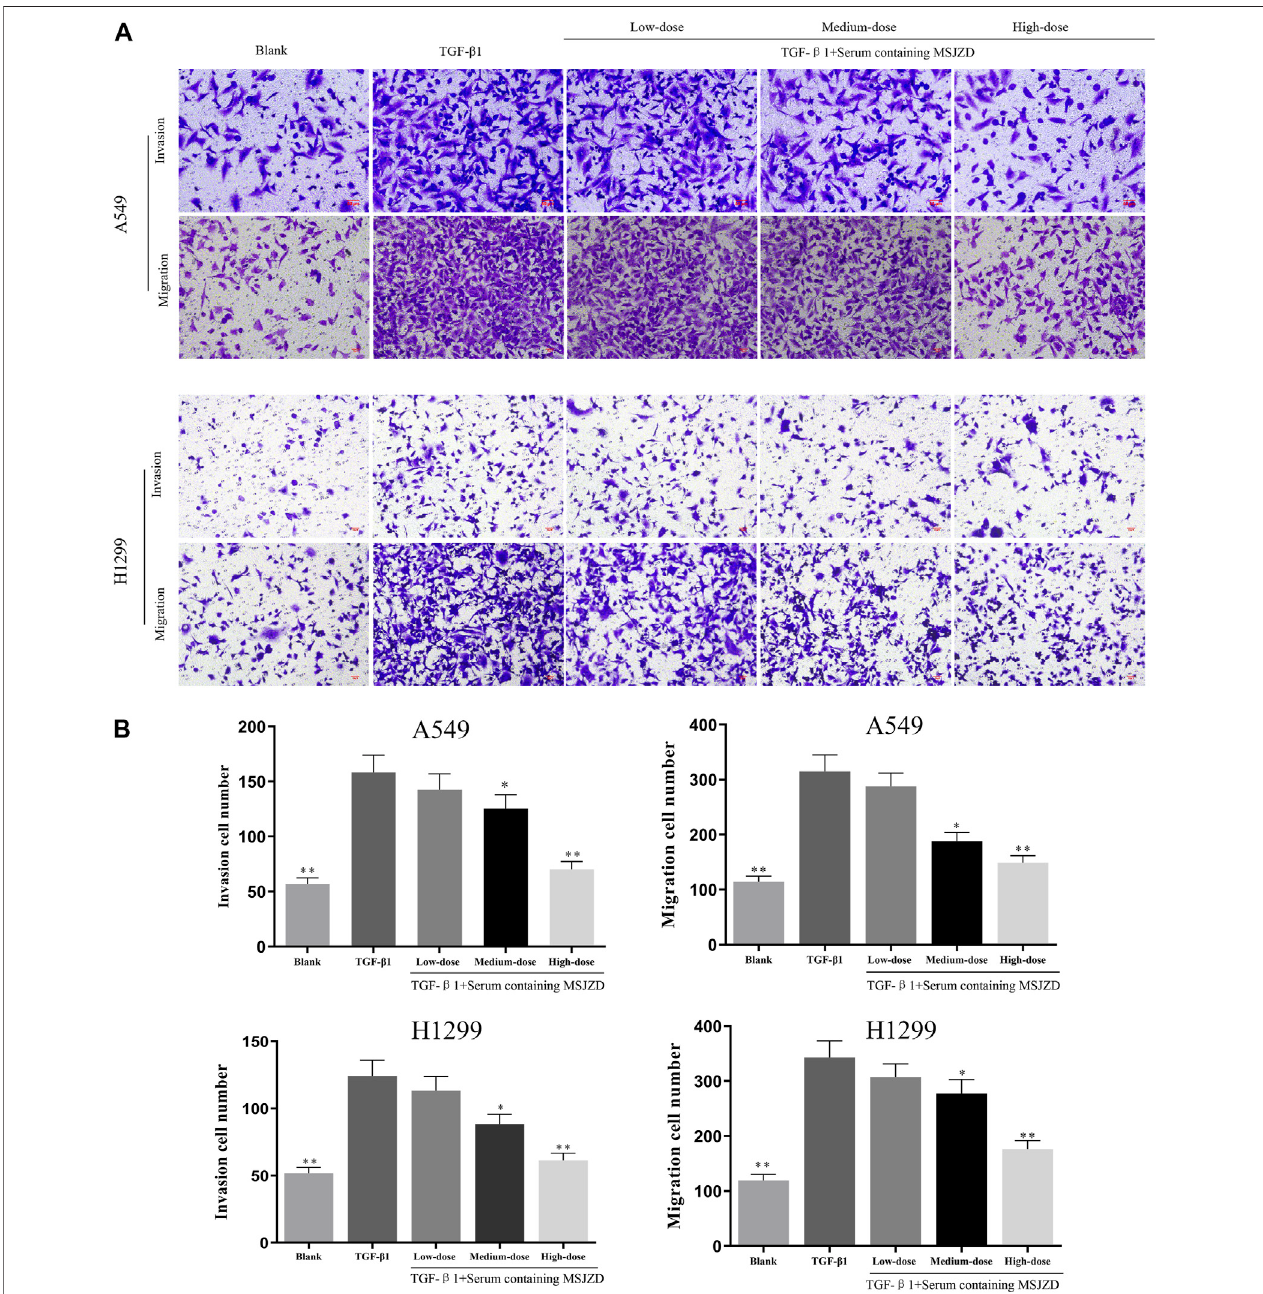
FIGURE4| Serum-containing MSJZD mitigated themigration andinvasioninNSCLCcells triggered byTGF- β 1. (A) Transwell assayswereconductedtoexamine theeffectsofserum-containingMSJZDonA549andH1299cellmigrationandinvasion. (B) StatisticalanalysisofinvasionandmigrationcellnumberinA549andH1299 cells. * p < 0.05, ** p < 0.01. versus the TGF- β 1 group.